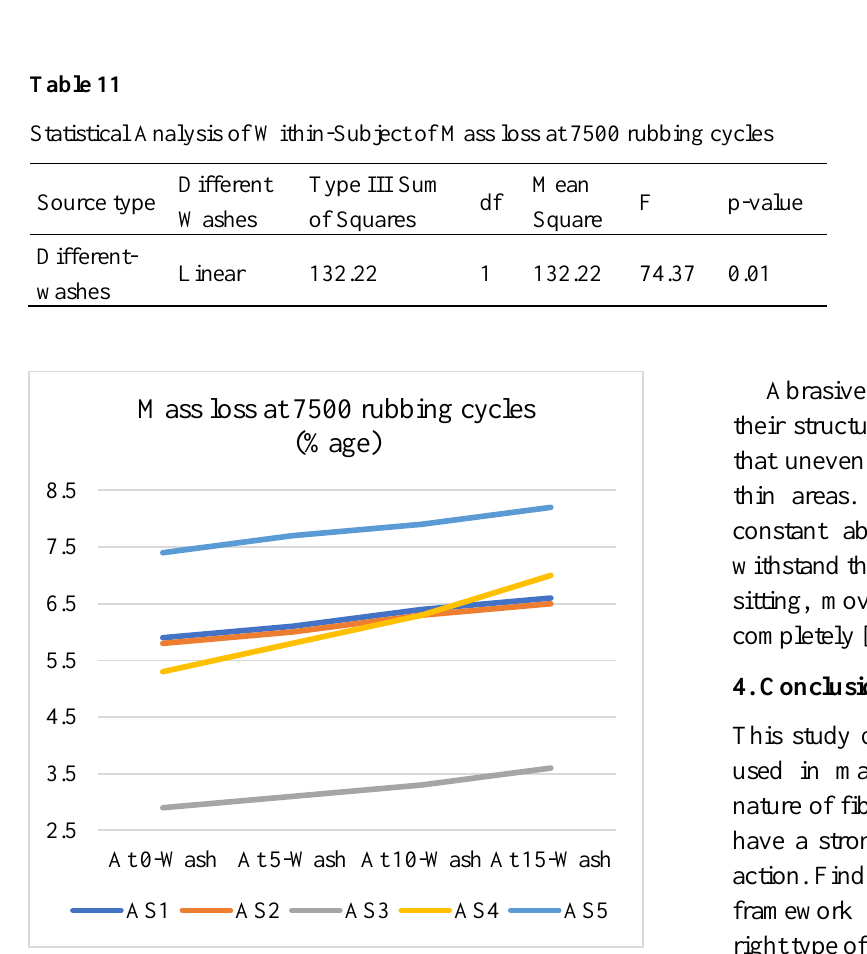
Fig. 5. Mass loss at 7500 rubbing cycles at various washing